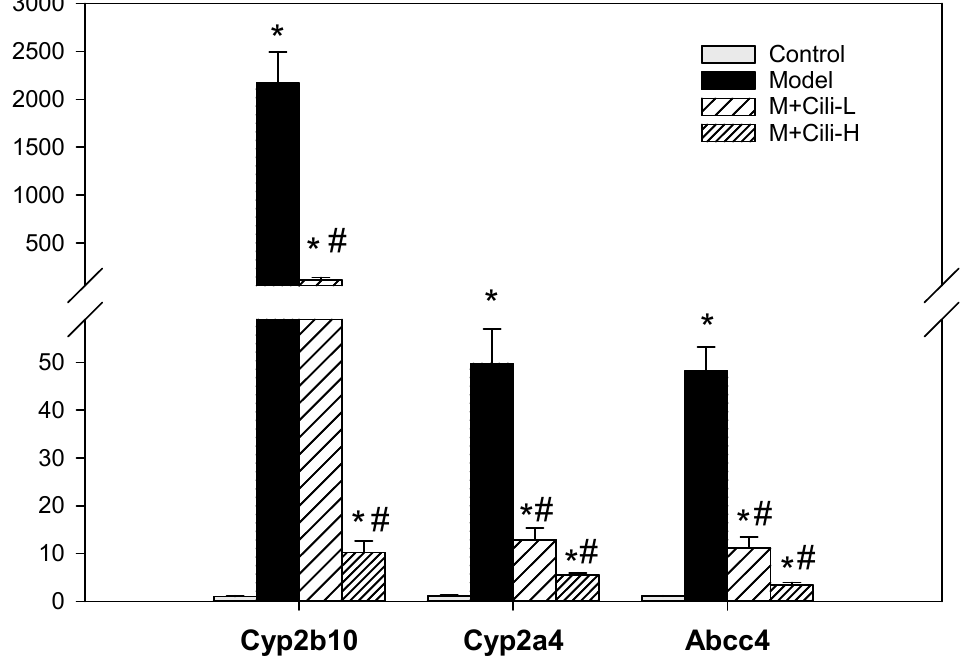
Figure 7. The qPCR analysis of the constitutive androstane receptor (CAR) and pregnane X receptor (PXR) biomarkers among groups. Data are mean ± SEM ( n = 8), * Significantly different from the Control group, p < 0.05; # Significantly different from the Model group, p < 0.05.